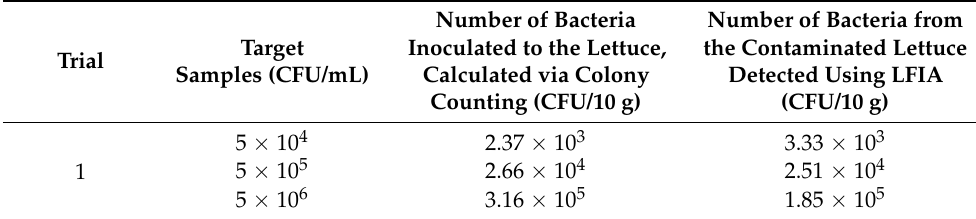
Table 1. Comparison between the number of bacteria inoculated from counting colonies and the number of bacteria inoculated from the device performing multistep immunoassay on a lateral flow